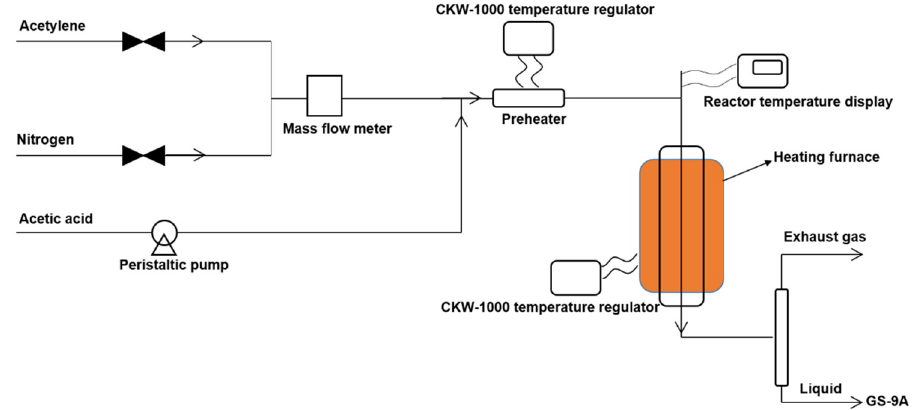
Figure 8. Flow chart of activity determination.